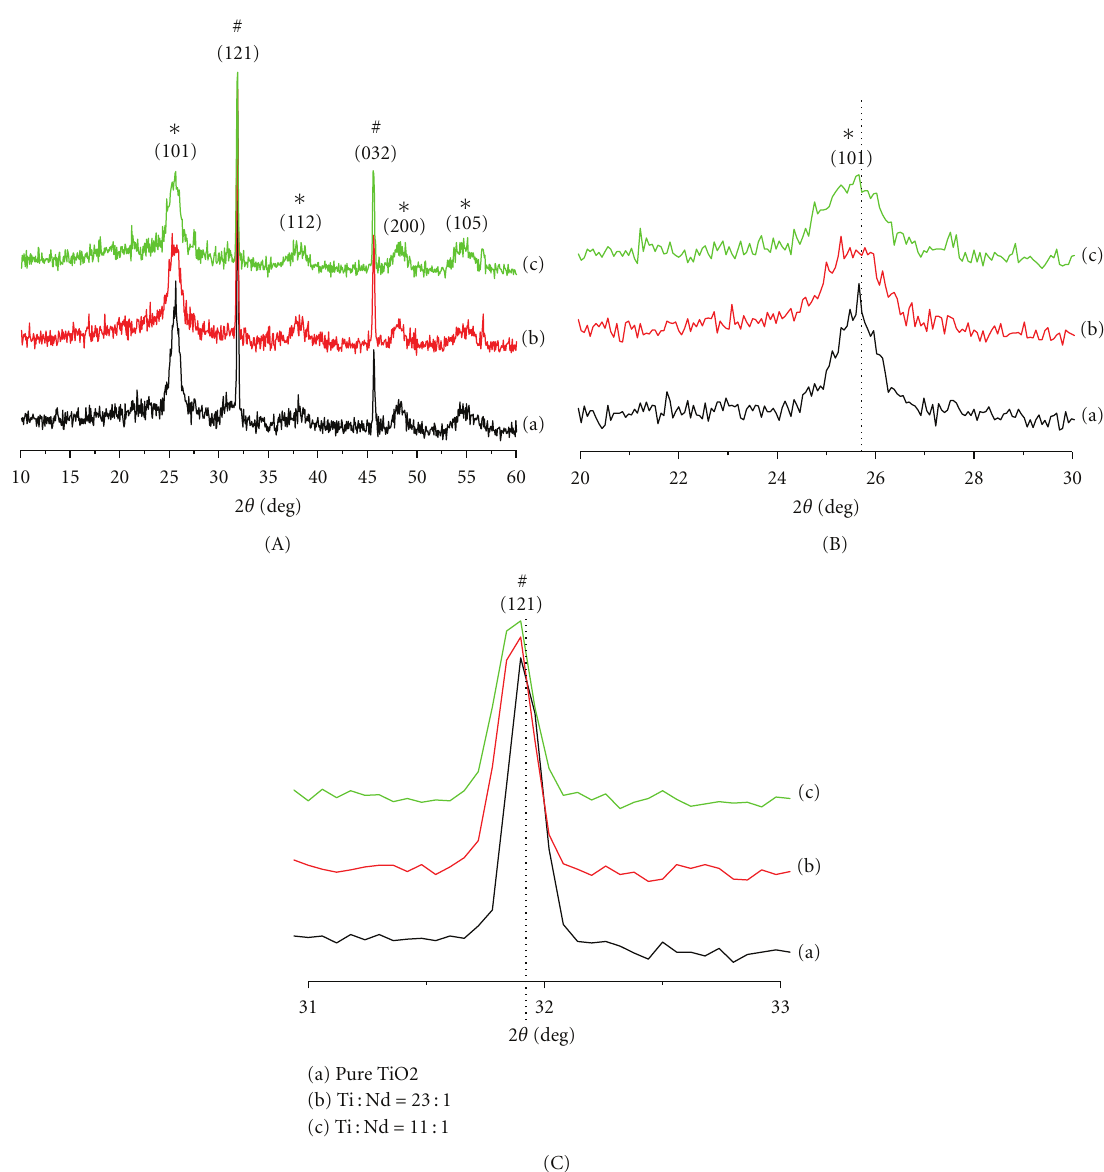
Figure 1: (A) XRD patterns of pure TiO 2 (a), Nd-doped TiO 2 with Ti:Nd = 23:1 (b), and Nd-doped TiO 2 with Ti:Nd = 11: 1 (c). ∗ anatase, # brookite. (B) The enlarged peak at (101) plane and (C) enlarged peak at (121) plane.